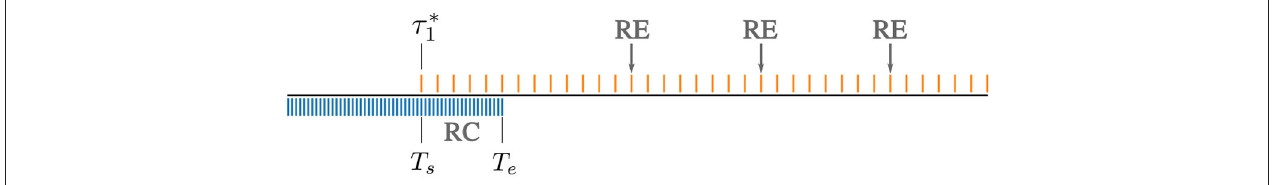
FIGURE 1 | Structure of ATSA. For a bidisperse blend of short and long chains, the fine-grained time-step 1 t fg (blue grid) is initially controlled by the short chains. Recalibration (RC) is triggered at time T s = τ ∗ 1 , when the short chains completely relax. For times T s ≤ t ≤ T e , the dynamics are evolved using two time-steps 1 t fg (blue) and a larger coarse-grained 1 t cg (orange). Beyond, T e the suitably adjusted larger time-step is used to further evolve the dynamics. Re-equilibration (RE) is performed periodically, approximately at intervals of τ ∗